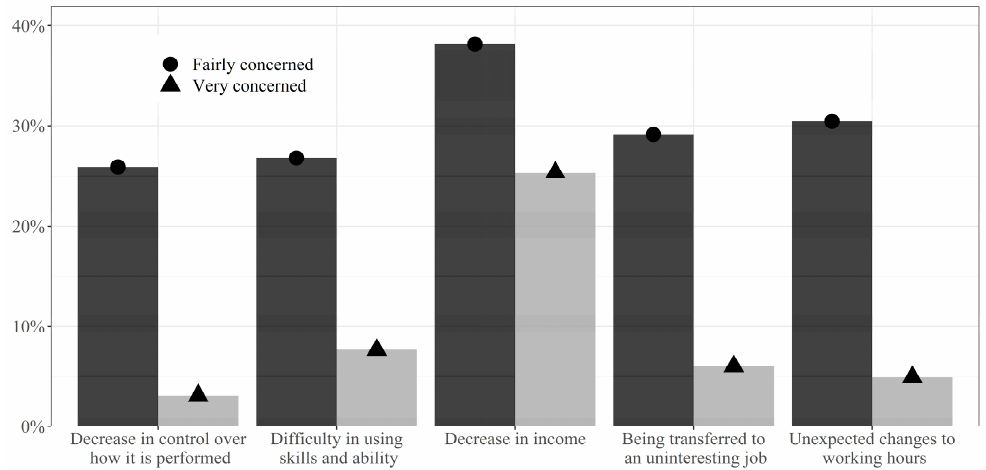
Figure 1. Prevalence of concern regarding each situation that may result from technological automation in the future. tion in the